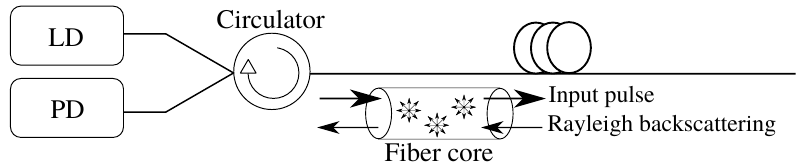
Figure 2. Principle scheme of